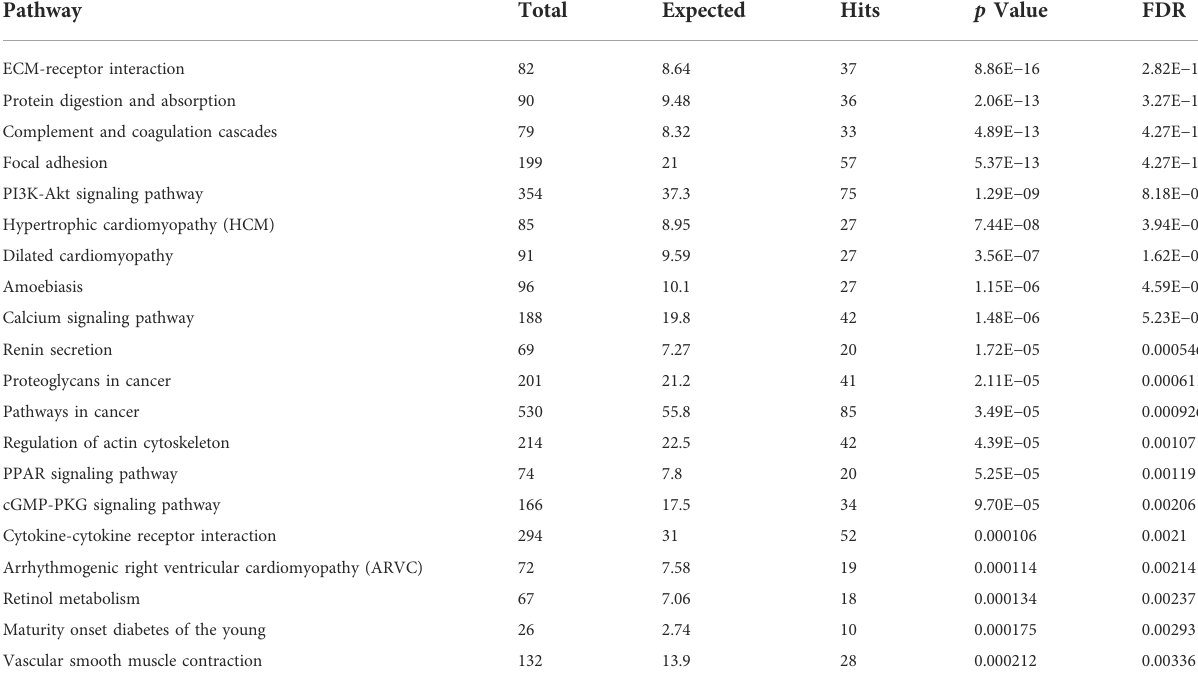
TABLE 4 List of identi fi ed TOP20 KEGG pathways based on the upregulated DEGs in DMD-COs (Cut-off log2FC > 1.5, Cut-off p -value < 0.05). Pathway